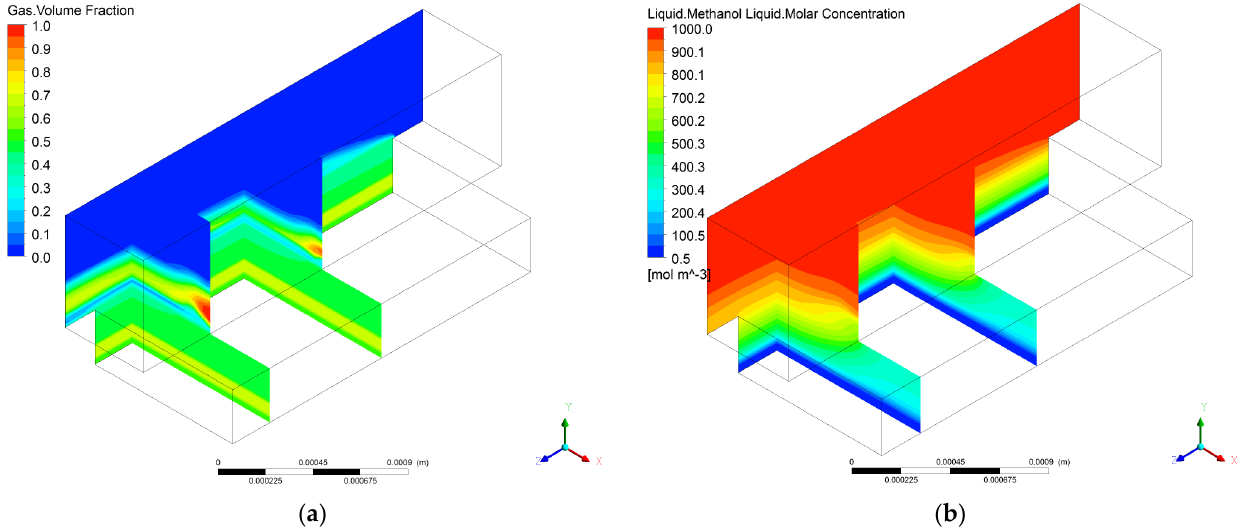
Figure 7. ( a ) Three-dimensional liquid saturation distribution and ( b ) three-dimensional liquid phase methanol concentration distribution in the anode channel and electrode at a GDL porosity of 0.75, cell voltage of 0.3 V and a current density of 0.17 A/cm 2 . The flow direction is from right, back, to left, front.